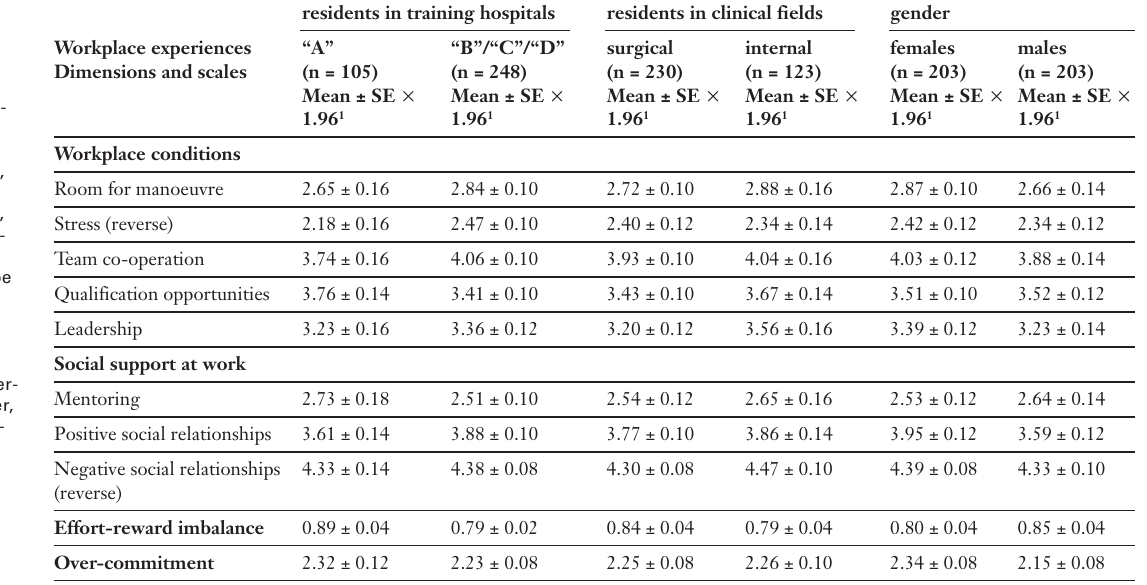
Multivariate analyses of covariance.